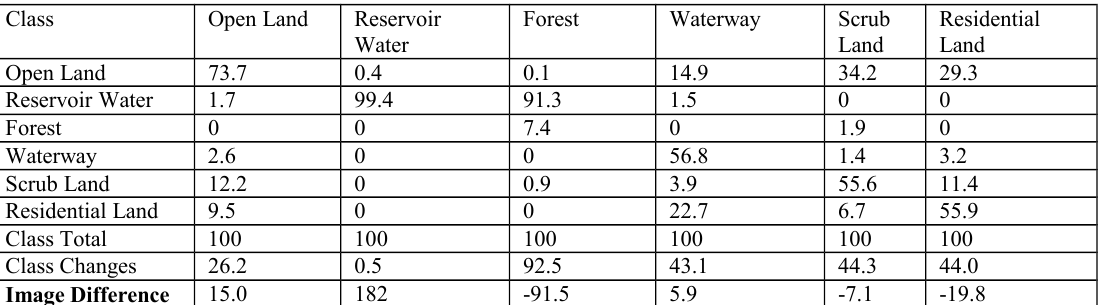
Table 4: Winter to Autumn Season Change Detection Percentage